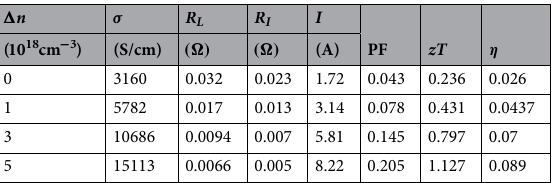
Table 1. The electrical conductivity σ , electric current I , power factor PF , figure of merit zT , and the conversion efficiency η vary with the incremental doping concentration, (cid:31) n